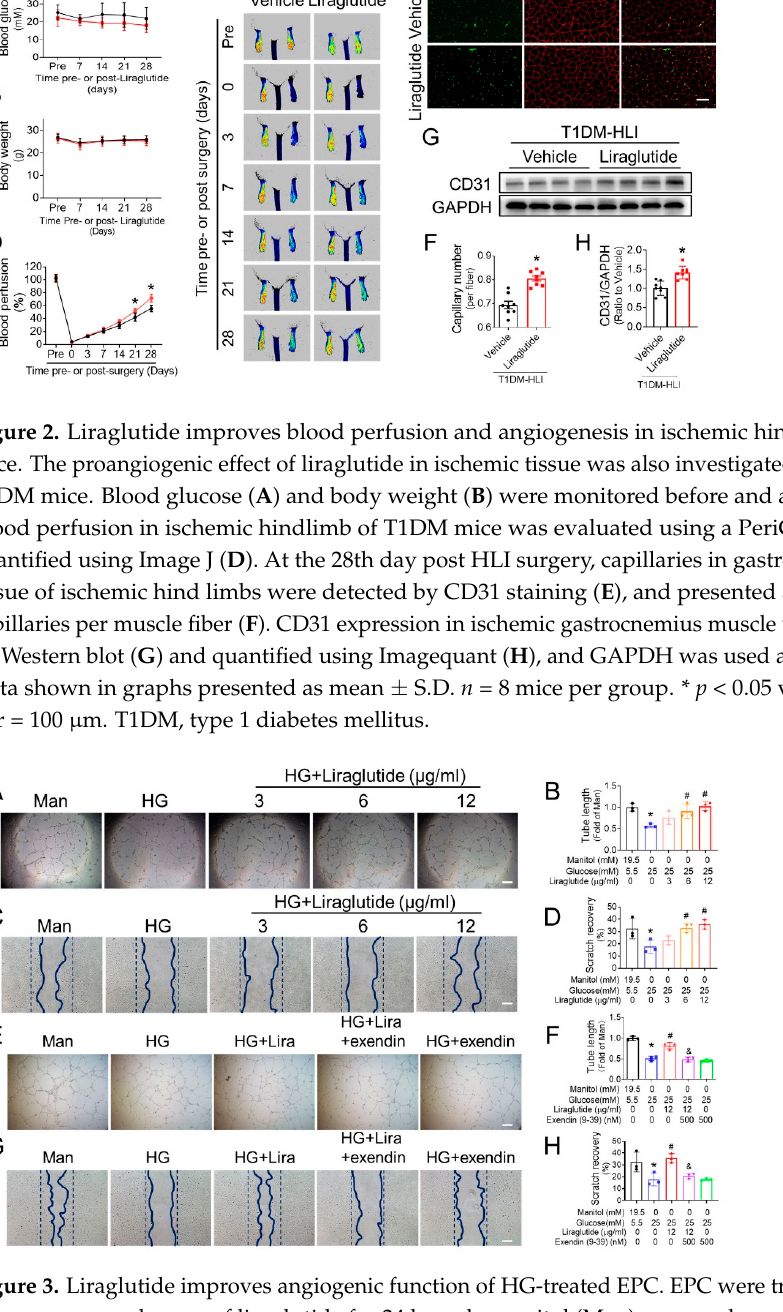
Figure 3. Liraglutide improves angiogenic function of HG-treated EPC. EPC were treated with